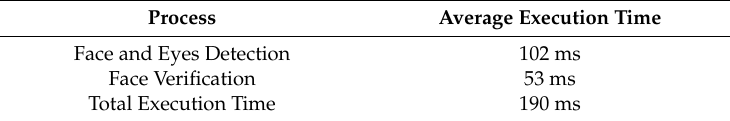
Table 4. The average execution times (millisecond) of the proposed access control system for processing one image frame.